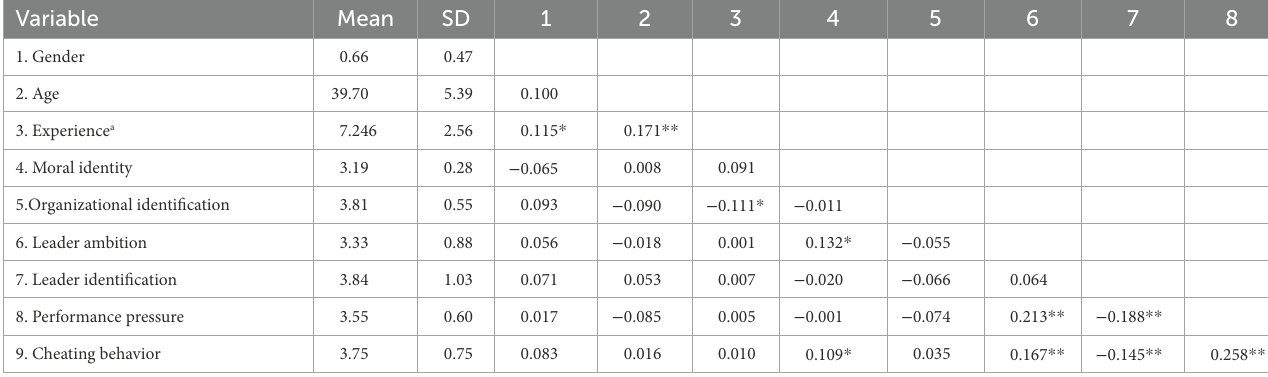
TABLE 3 Study 2- means, standard deviation, and correlation among study variables. Variable